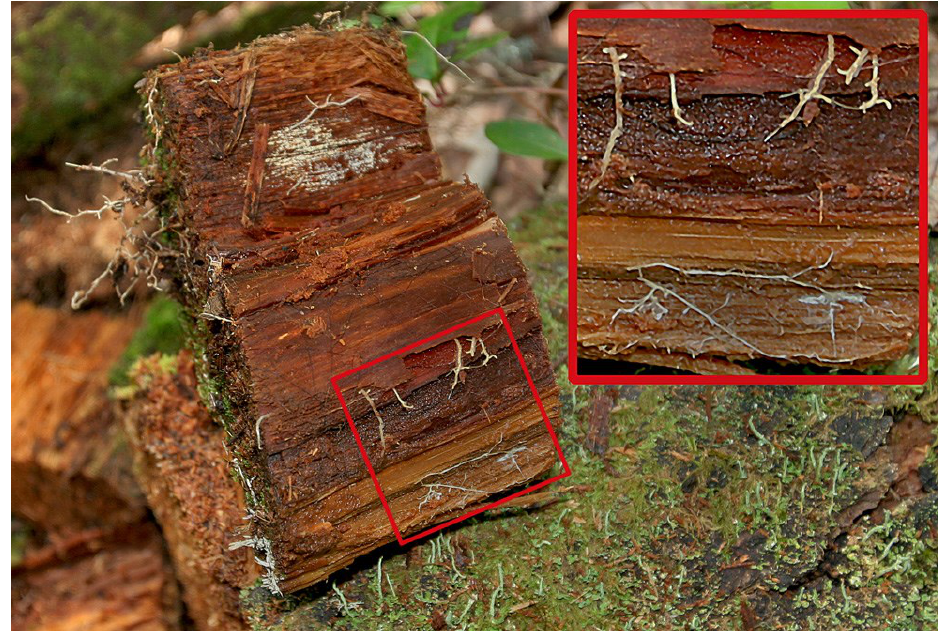
Figure 9. Decayed spruce stem section penetrated by fine roots, mycelium, and mycelial cords (insert) after 12 years of decay with ground